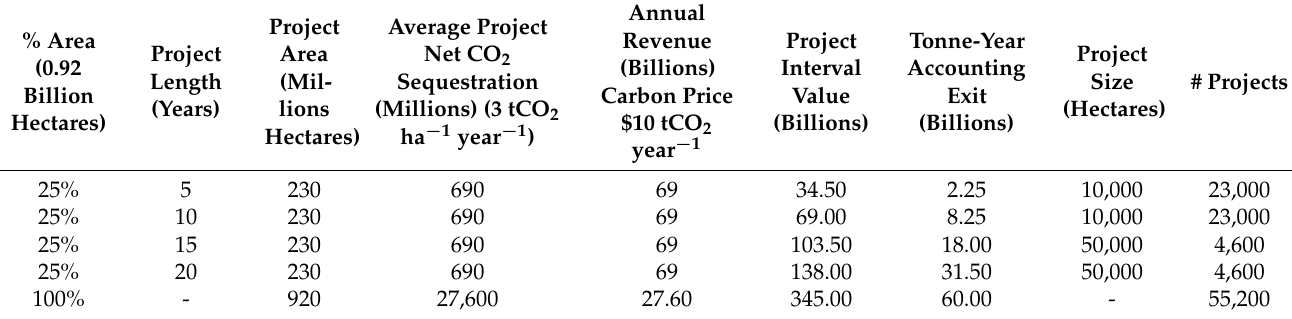
Table A2. Forest sequestration project analysis summary for ~0.92 billion